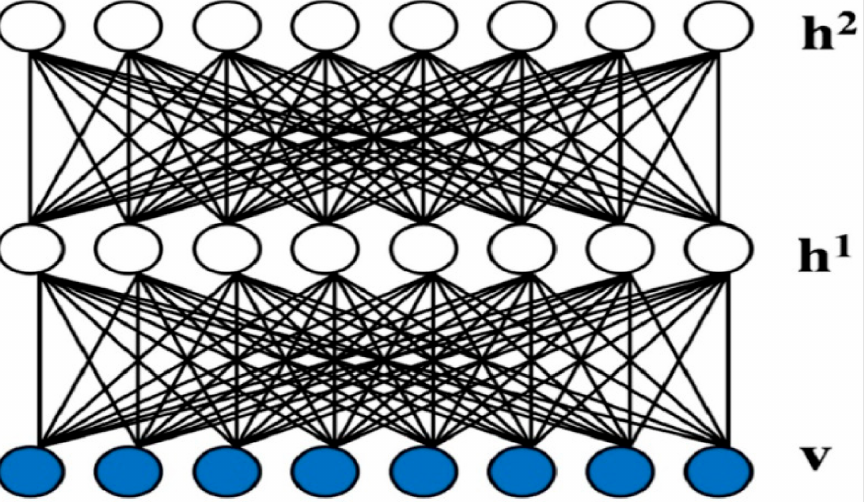
Figure 4. The configuration of the DBM. Copyright © 2021 Elsevier